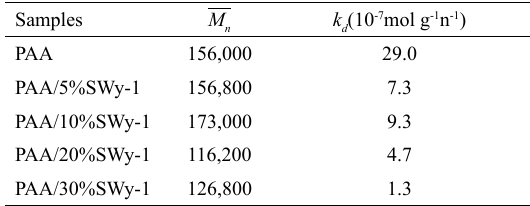
Table 1. Initial Number Average Molecular Weights and photodegradation rates of PAA and nanocomposite